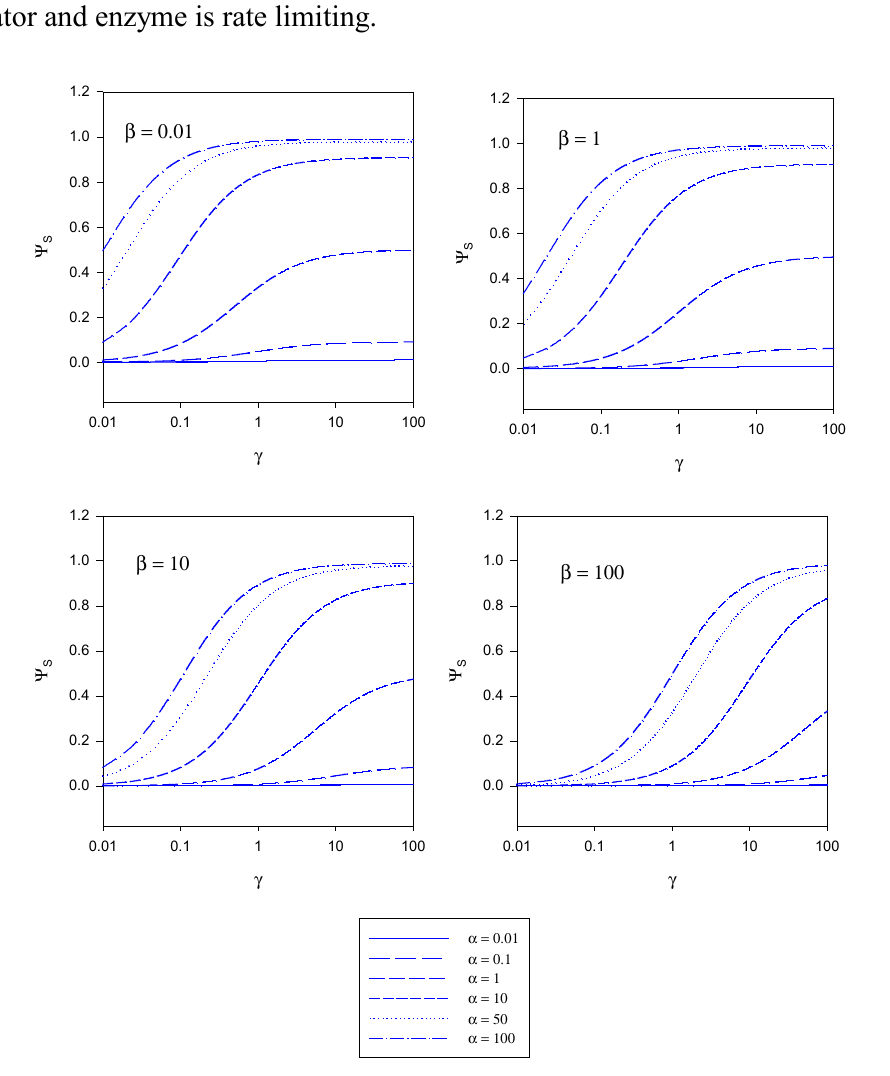
Figure 4. Variation of the normalized substrate flux with the kinetic competition parameter γ computed from eqn. 20. The plots are computed for different values of the substrate saturation parmeter α . Each set of curves corresponds to a fixed value of the mediator saturation parameter β